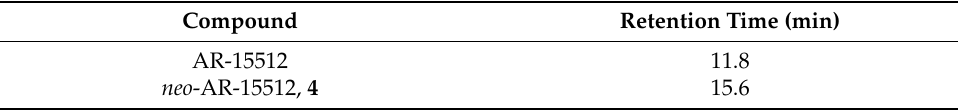
Table 1. Retention times of AR-15512 and its diastereomer 4 .